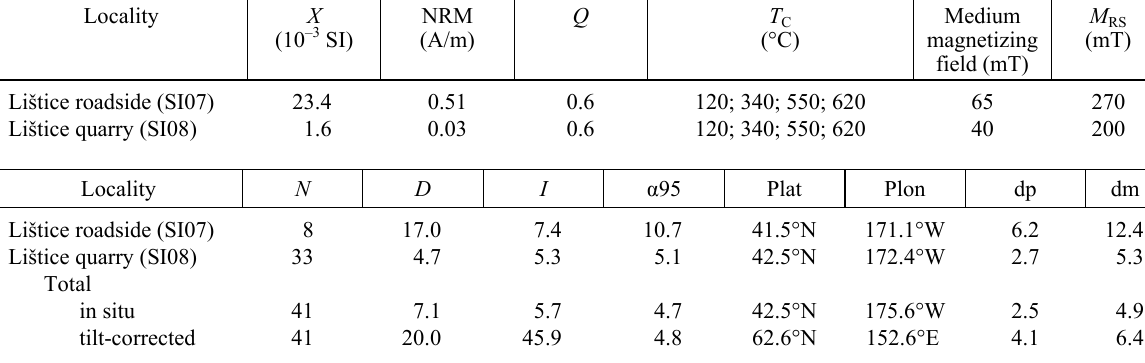
Table 1. Rock magnetic and palaeomagnetic